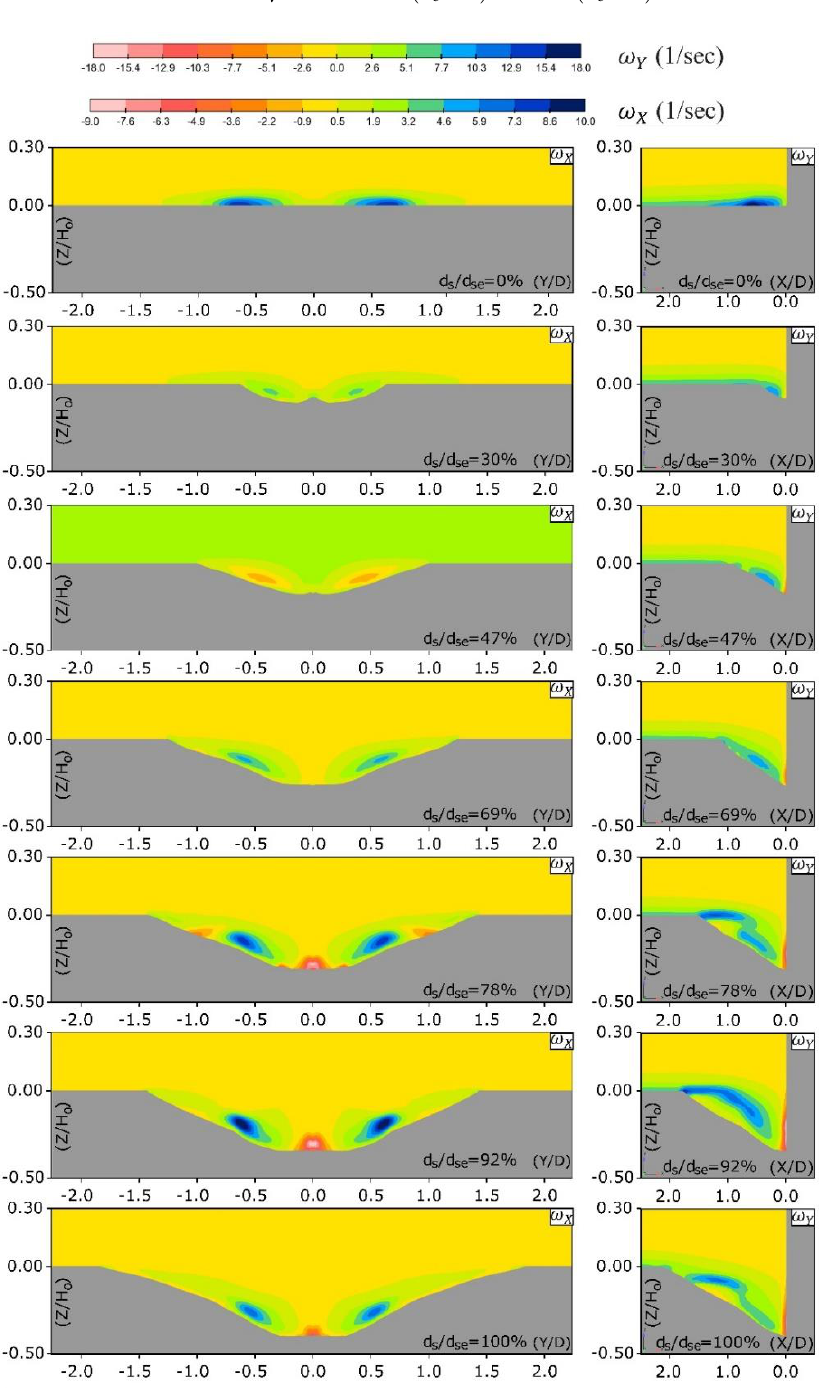
Figure 15. Evolution of Y-vorticity ( ω Y ) at the vertical plane of symmetry, and X-vorticity ( ω X ) during scouring process at ( X / D = 0.0 ) .